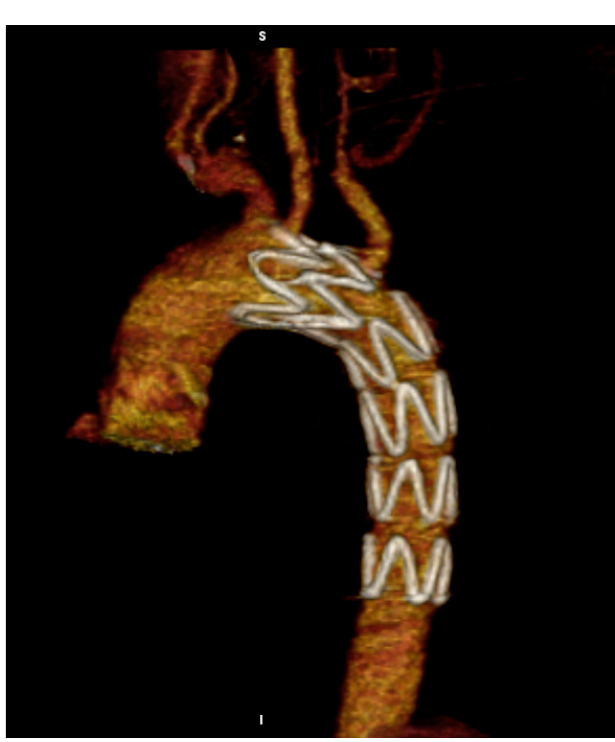
Fig. 2D - Volume-rendered three-dimensional follow-up computed tomography angiography imaging showing the endograft deployment in zone 2 and the exclusion of primary thoracic aortic mural